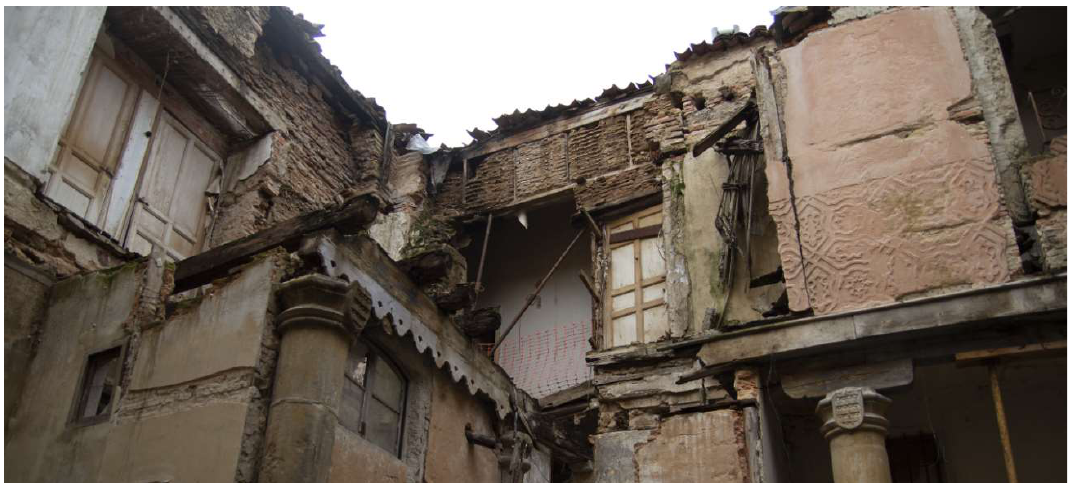
Figure 8. Main cloister; detail of a collapsed wooden floor due to the rotting of the beams.